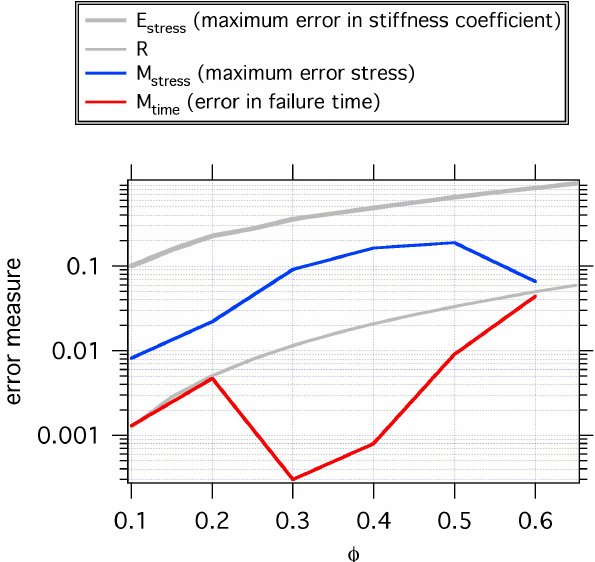
Fig. 9. Errors in the BHM for repeated slip of an asperity as φ is varied between 0.1 and 0.6. Equations (5a) and (5b) are used in the Barnes-Hut scheme on a plane strain fault grid of 40m length. The asperity is 10m long. The errors associated with the stiffness coef- ficients ( E k , Eq. 7 thick grey line), with shear stress ( M , blue) and with failure time ( M , red) are shown. These are from the numerical simulations. Shown also is R (Eq. 8,